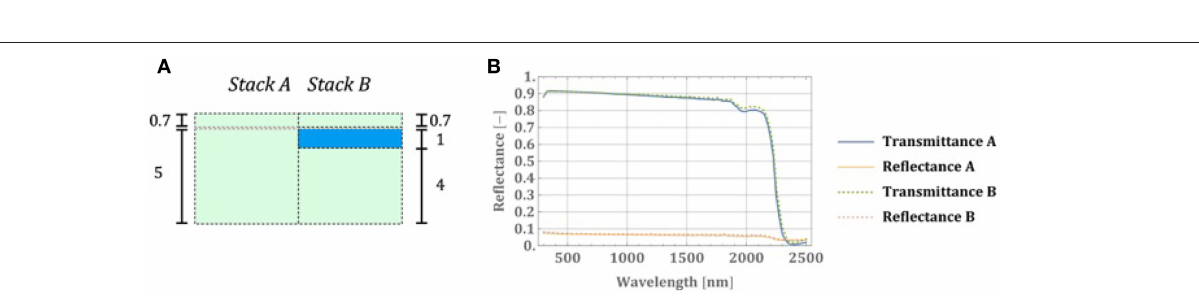
Frontiers in Materials |